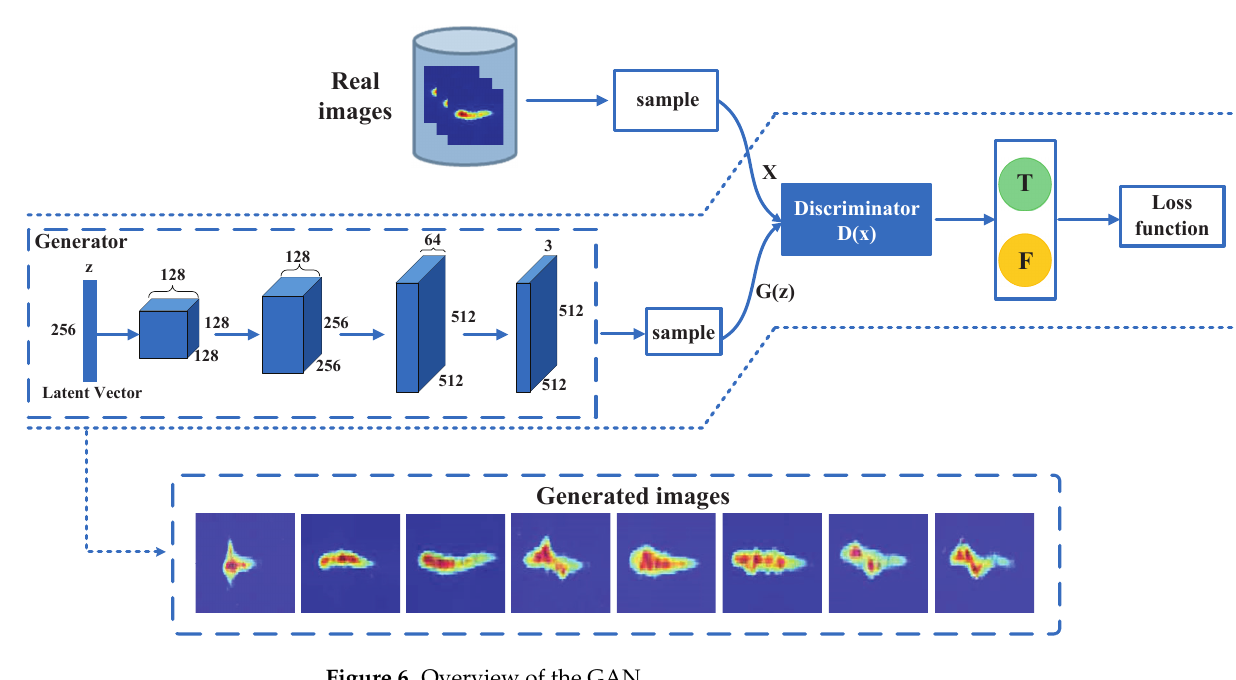
Figure 6. Overview of the